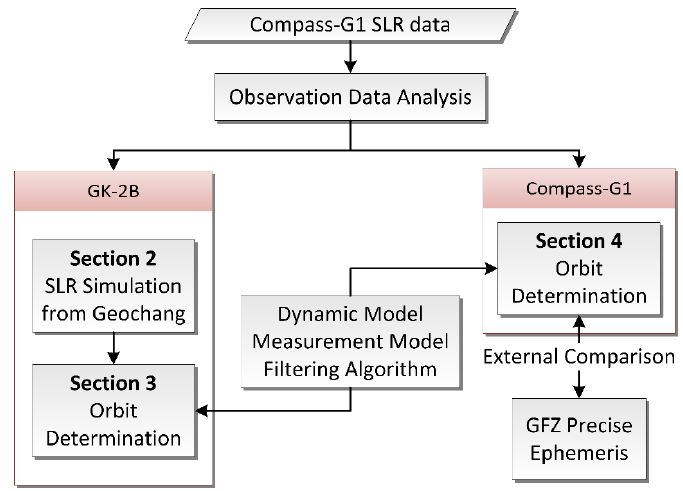
Figure 1. Orbit determination procedure. SLR—satellite laser ranging; GFZ—GeoForschungsZentrum.